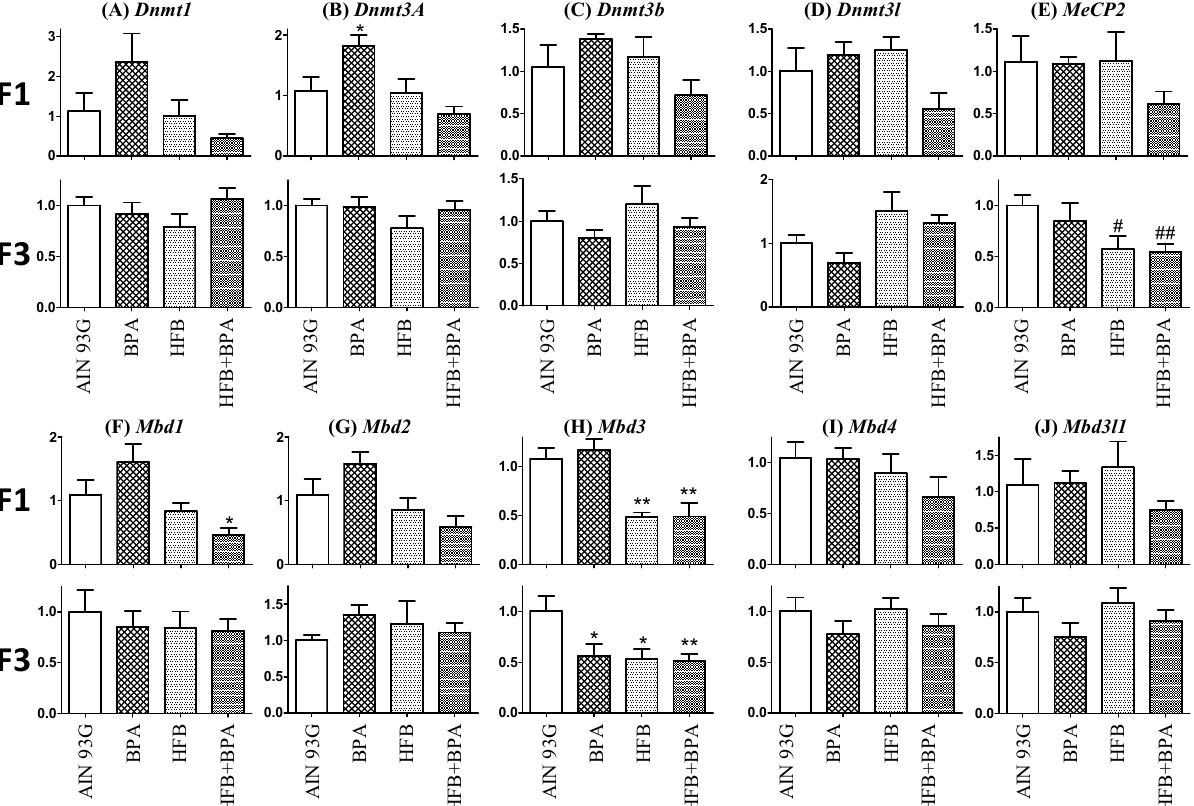
Figure 8. Relative gene expression was determined by real-time PCR for ( A ) Dnmt1 , ( B ) Dnmt3a , ( C ) Dnmt3b , ( D ) Dnmt3l , ( E ) MeCP2 , ( F ) Mbd1 , ( G ) Mbd2 , ( H ) Mbd3 , ( I ) Mbd4 , and ( J ) Mbd3l1 . RNA was isolated from testes of F1- and F3-generation AIN, BPA, HFB, and HFB + BPA groups following T + E2 implantation. Relative expression ratio (RER) was calculated by normalizing transcript levels of a gene to that of Rpl19 transcript level in the same sample. Levels of transcripts in all other treatment groups at various life stages were normalized to AIN controls. Statistical significant differences are indicated (* p < 0.05, ** p < 0.01 when comparing values with one-way ANOVA and # p < 0.05, ## p < 0.01 when compared by T-test with AIN group).